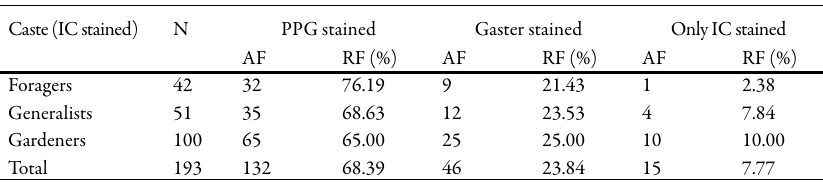
* Frequencies followed by distinct letters on the line differ with each other by the Chi-Square test (P<0.05). ns: Not significant by the Chi-Square test (P<0.05). Table 3 - Absolute and relative frequency of A. capiguara workers presenting stained PPG and gaster, among those with IC stained by Sudan III. IC: infrabuccal cavity; PPG: post-pharyngeal glands; AF: absolute frequency; RF: relative frequency.